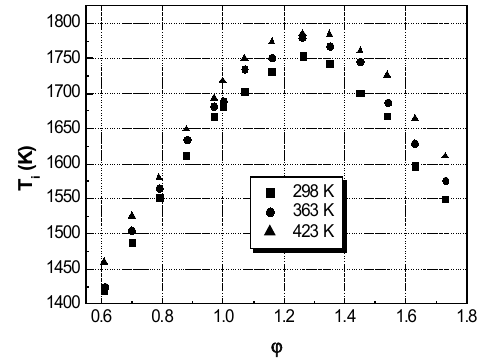
(b) Stoichiometric C